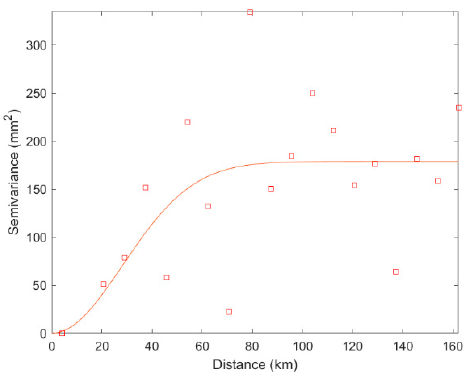
Figure 4. Sample variogram for the dense network (square symbols) with fitted model (solid curve).